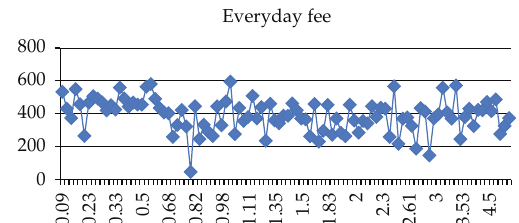
Figure 2: The line graph of Fugle-Meyer baseline e ff ect and the average cost in Chinese medicine group.